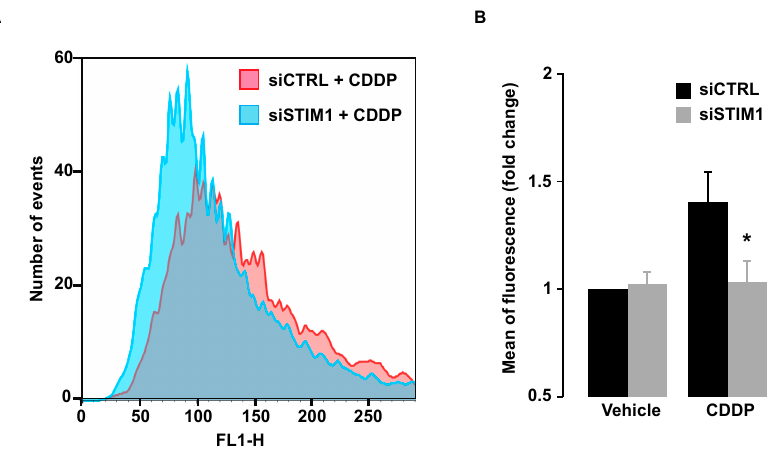
Figure 7. Cytofluorometric assessment of ROS generation. ( A ) Following transient transfection (for 72 h) with either siRNA downregulating STIM1 (siSTIM1) or with a control siRNA (siCTRL), A549 cells were left untreated or treated for additional 24 h with 25 µM CDDP, and labeled with H2DCFDA for ROS detection. ( B ) Quantification of data presented in A . Data are normalized to control conditions (i.e., siCTRL transfected cells without CDDP) and presented as the mean of three independent experiments ± S.D. ANOVA test was employed to assess statistical significance. * p < 0.05.